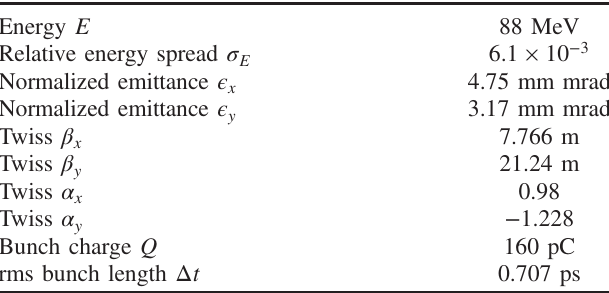
TABLE III. Experimental condition of the beam at the linac exit.